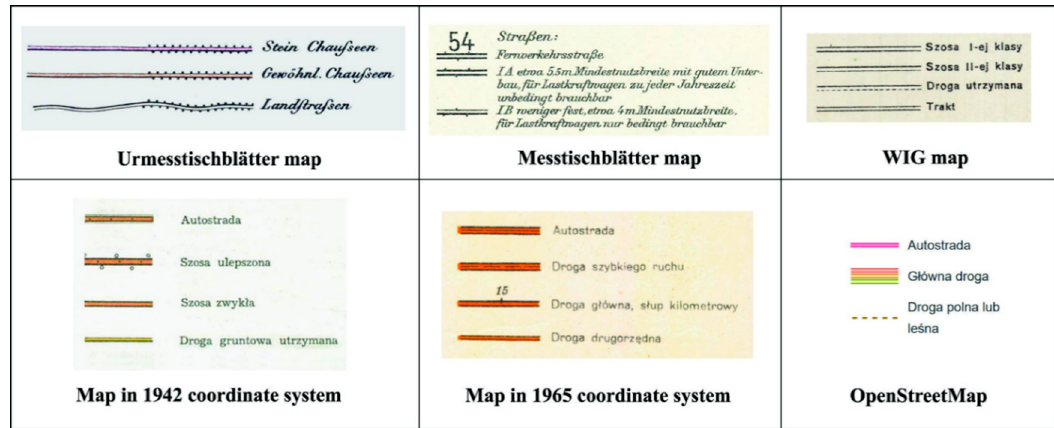
Figure 3. Ways of presenting the highest category of roads in the legends of the six maps.